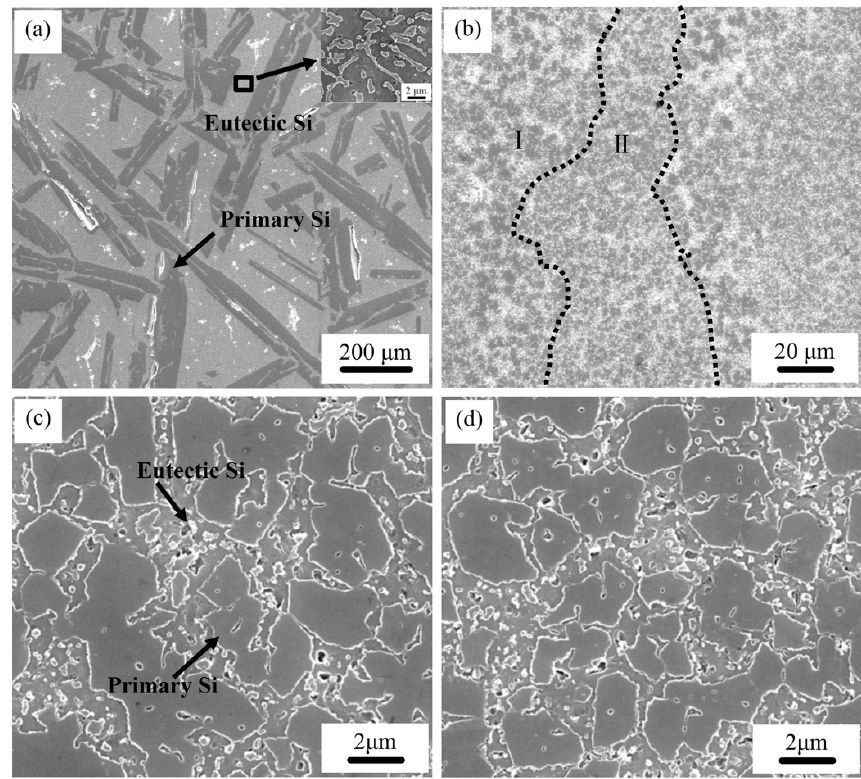
Figure 26. Microstructures of as-cast and SLM processed Al-50Si alloys. ( a ) As-cast alloy; ( b ) SLM alloy. ( c ) Part I in ( b ); ( d ) Part II in ( b ) [90]. Copyright 2017. Adapted with permission from Elsevier Science Ltd. under the license number 4803721234381 (Figure 1 [90]), dated 7 April 2020.